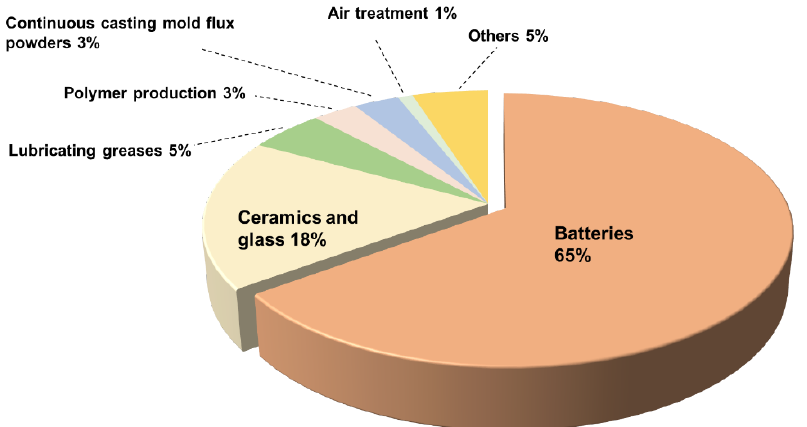
Figure 1. Distribution of global end-use markets of lithium.